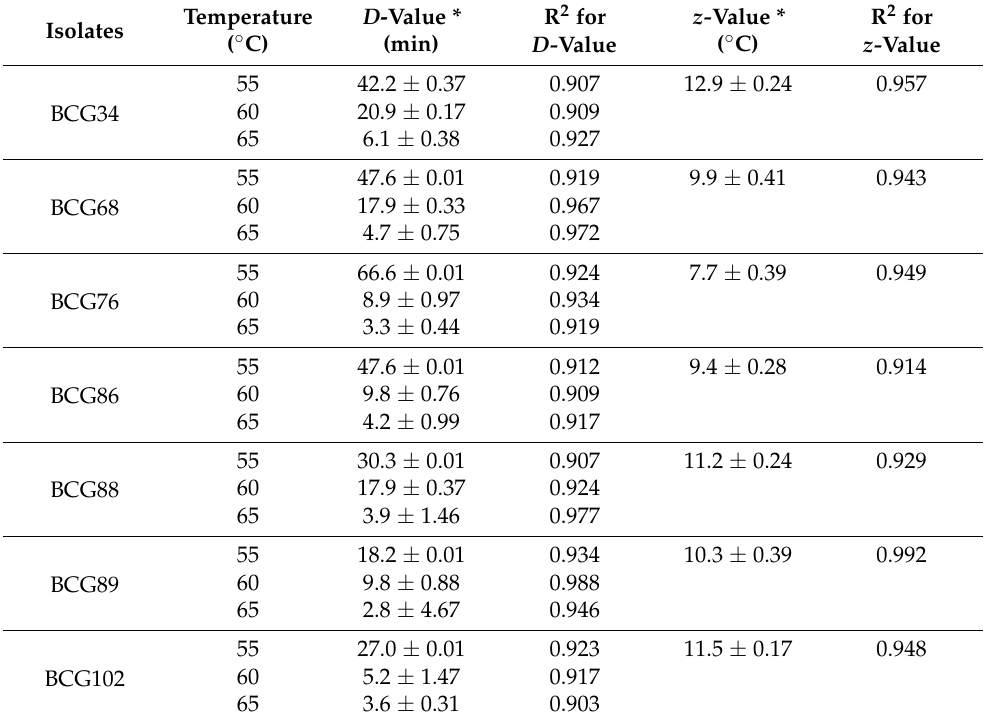
Table 2. D-(min) and z -values ( ◦ C) of psychrotolerant Bacillus cereus group (BCG) strains activated at 10 ◦ C at different